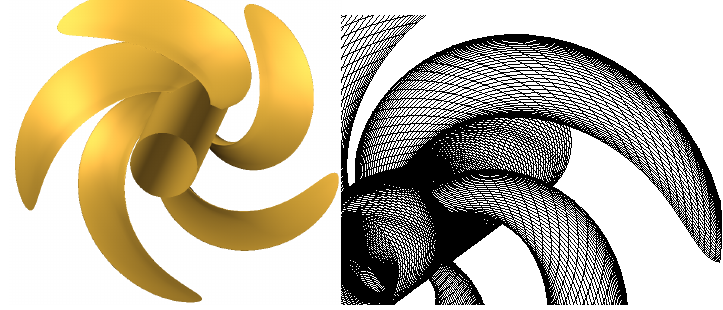
Figure 2. Propeller DTMB P4384. The panelling used in PROCAL is shown at the